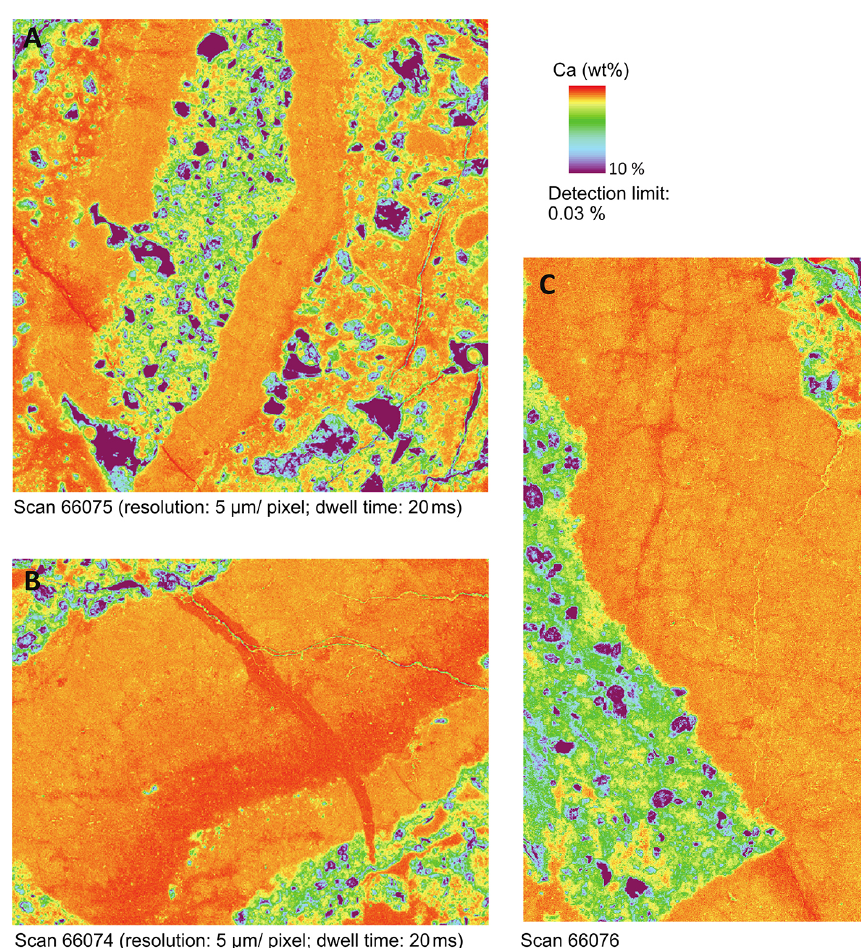
Figure B4. Fine scan of the investigation areas on sample 17NP436a for Ca.